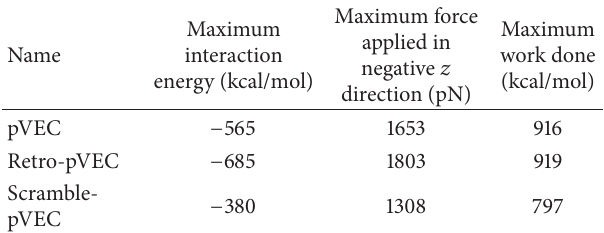
Table 3: The maximum interaction energy, maximum force applied, and maximum work done values for the pVEC